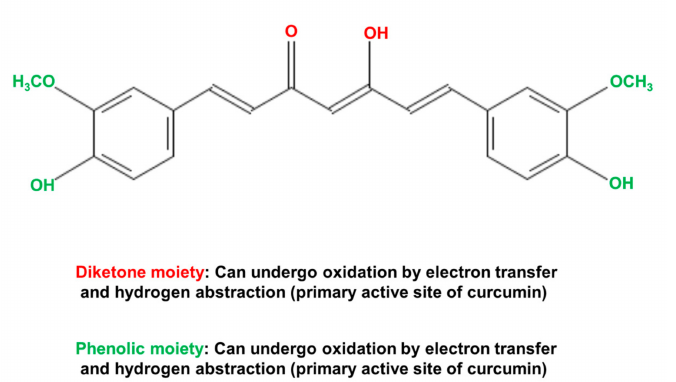
Figure 8. Chemical structure of the natural product curcumin (1E,6E)-1,7-bis(4-hydroxy-3- methoxyphenyl)-1,6-heptadiene-3,5-dione), which is derived from the spice turmeric ( Curcuma longa Linn). The diketone moiety (shown in red) and the two phenolic moieties (shown in green) are the reactive groups responsible for many of the biological actions of curcumin [120]. In rat hepatocytes, curcumin was found to inhibit the activation by ADP-ribose of TRPM2 currents, measured using whole cell patch clamp recording (Figure 9A,B). Curcumin also inhibited Ca 2+ entry through TRPM2 channels, measured in rat hepatocytes using patch clamp recording and Ca 2+ imaging, when these were activated by H 2 O 2 or acetaminophen. The IC 50 for curcumin, measured in HEK293T cells heterologously expressing TRPM2, was found to be about 50 nM (Figure 9C).